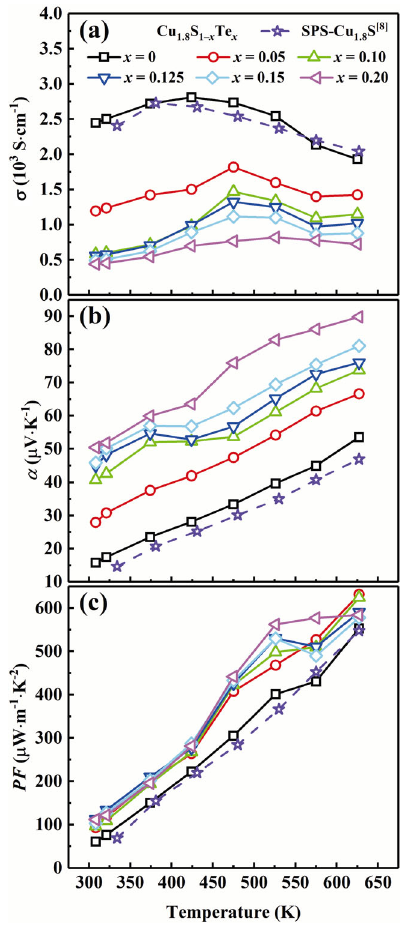
Fig. 3 Temperature dependence of electrical transport properties for Cu 1.8 S 1– x Te x bulks and the SPS-Cu 1.8 S bulk from: (a)  , (b)  , and (c) PF . Reproduced with permission from Ref. [8], © The Royal Society of Chemistry